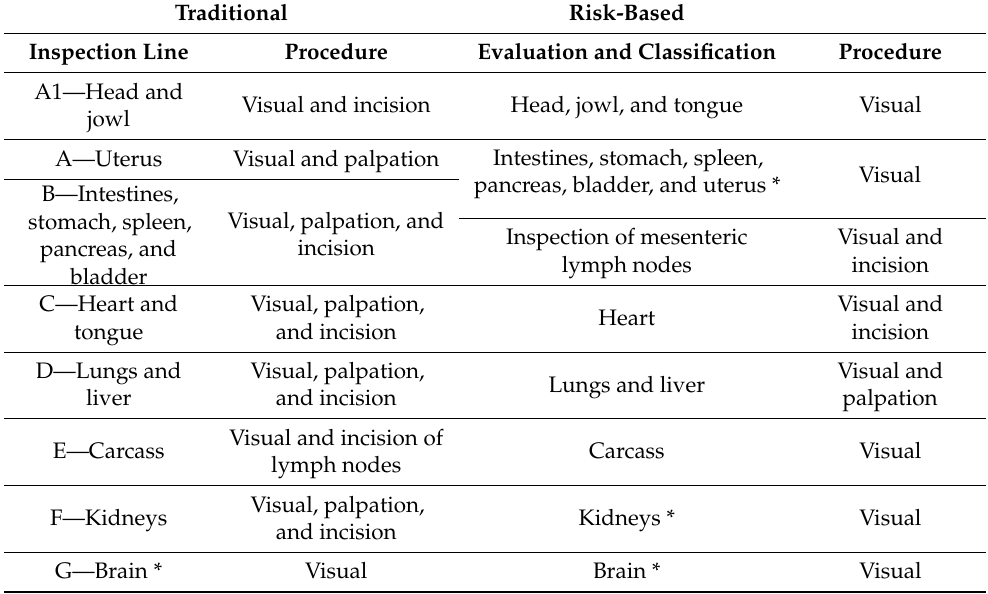
Table 1. Post-mortem procedures of traditional and risk-based